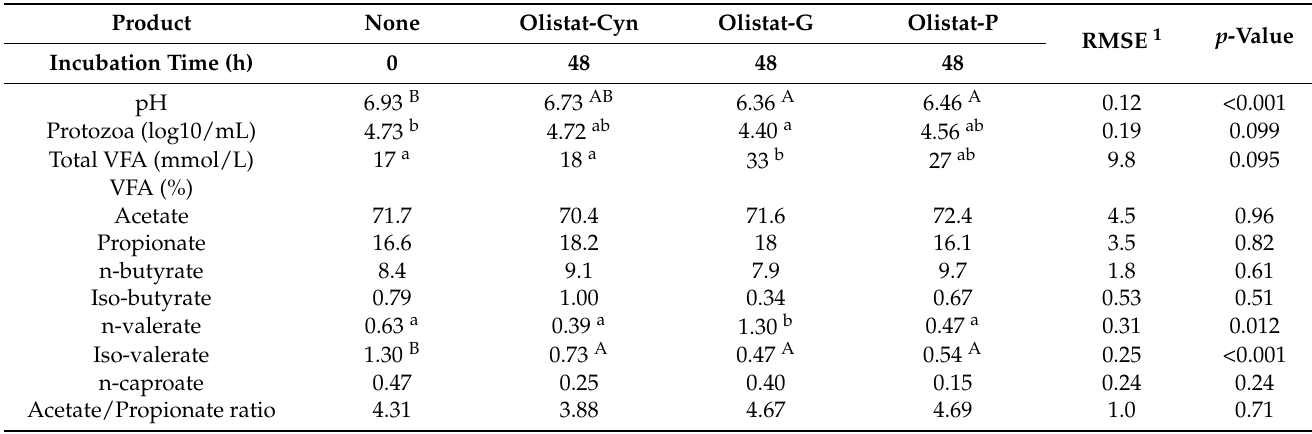
Table 2. LS means of the pH, protozoa number, and volatile fatty acids (VFA) profile, observed at 0 and 48 h of incubation of the essential oil